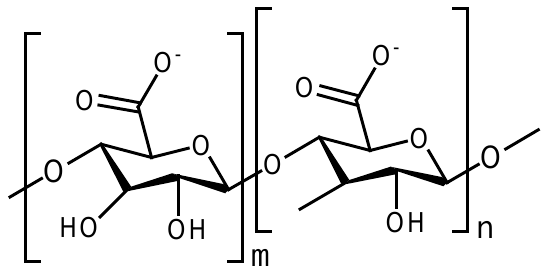
Figure 5. Chemical structure of alginate.